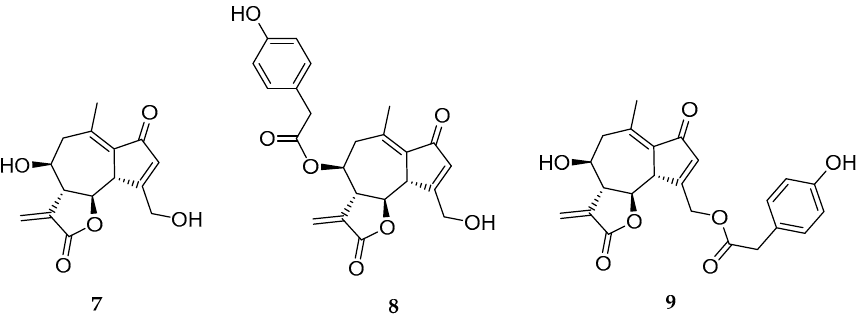
Figure 8. Structures of lactucin ( 7 ) and its derivatives lactupicrin ( 8 ) and lactucopicrin ( 9 ).